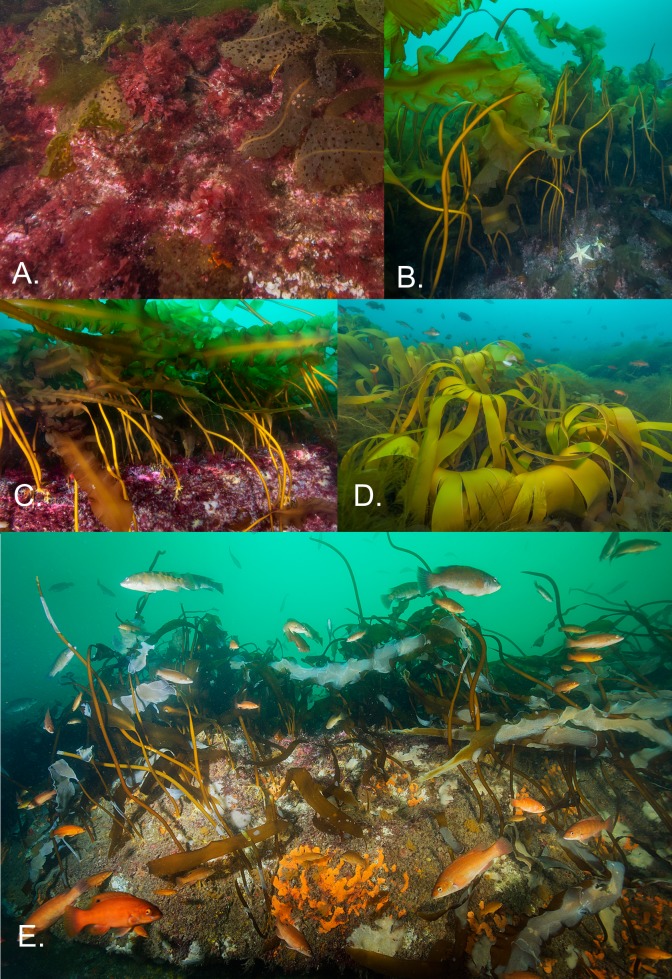
Kelp communities in the coastal zone and offshore on Cashes Ledge.A. view of common macroalgae at a coastal site, Mingo Rock. Blades of the dominant shotgun kelp Agarum clathratum are visible in addition to the red algae Euthora sp. and the invasive Dasysiphonia japonica. B. Side view of Saccharina latisssima forest at AR site 2 on Cashes Ledge, showing the tall stature and complexity of the habitat created by this foundation species. C. View of S. latissima forest at AR site 1 showing understory red algae and small colonies of the ascidian Aplidium constellatum. D. Patch of Saccharina digitata kelp at AR site 2 in 2015. S. digitata density is inversely related to that of S. latissima, suggesting interspecific competition. Small fish in the background are cunner (Tautogolabrus adspersus). E. Photo of a deteriorating assemblage of S. latissima kelp at AR1 site during the anomalously warm summer of 2012. Note the high incidence of kelp covered with white colonies of the invasive bryozoan Membranipora membranacea, kelp stipes lacking blades and abundant copper colored fish (cunner). Photo credits: Fig 6A, B and D by Brett Seymour, Fig 6C and E by Brian Skerry.